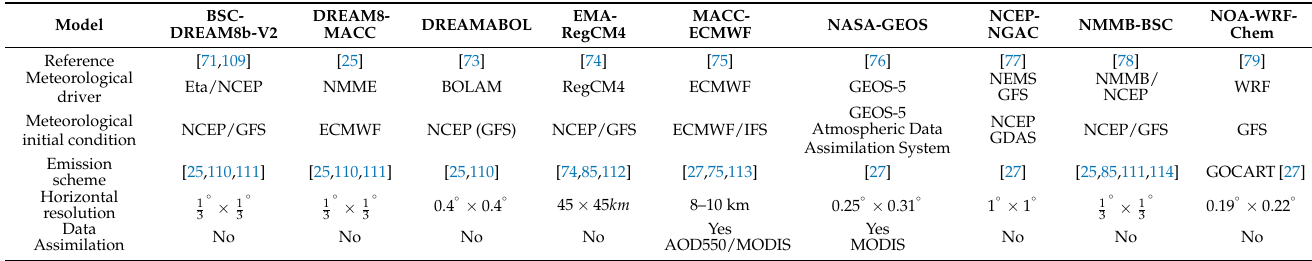
Table A1. Some specifications of the used operational dust forecasting